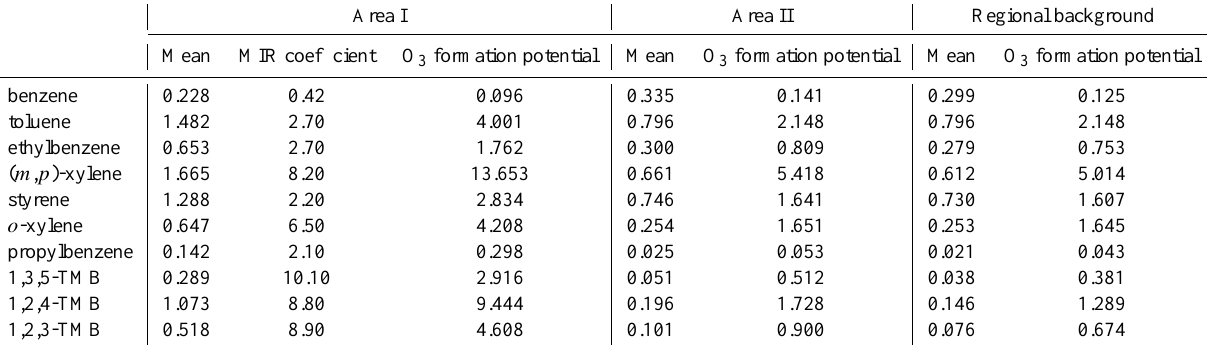
Table 2. Ozone formation potential of the aromatic hydrocarbon concentrations of air masses passing over the three source regions.